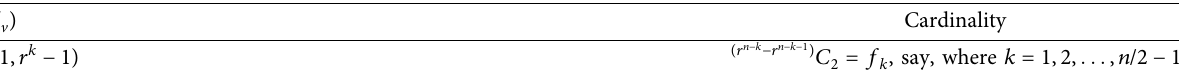
Table 8: Partition of pair of nodes ( u,v ) having distance 2.